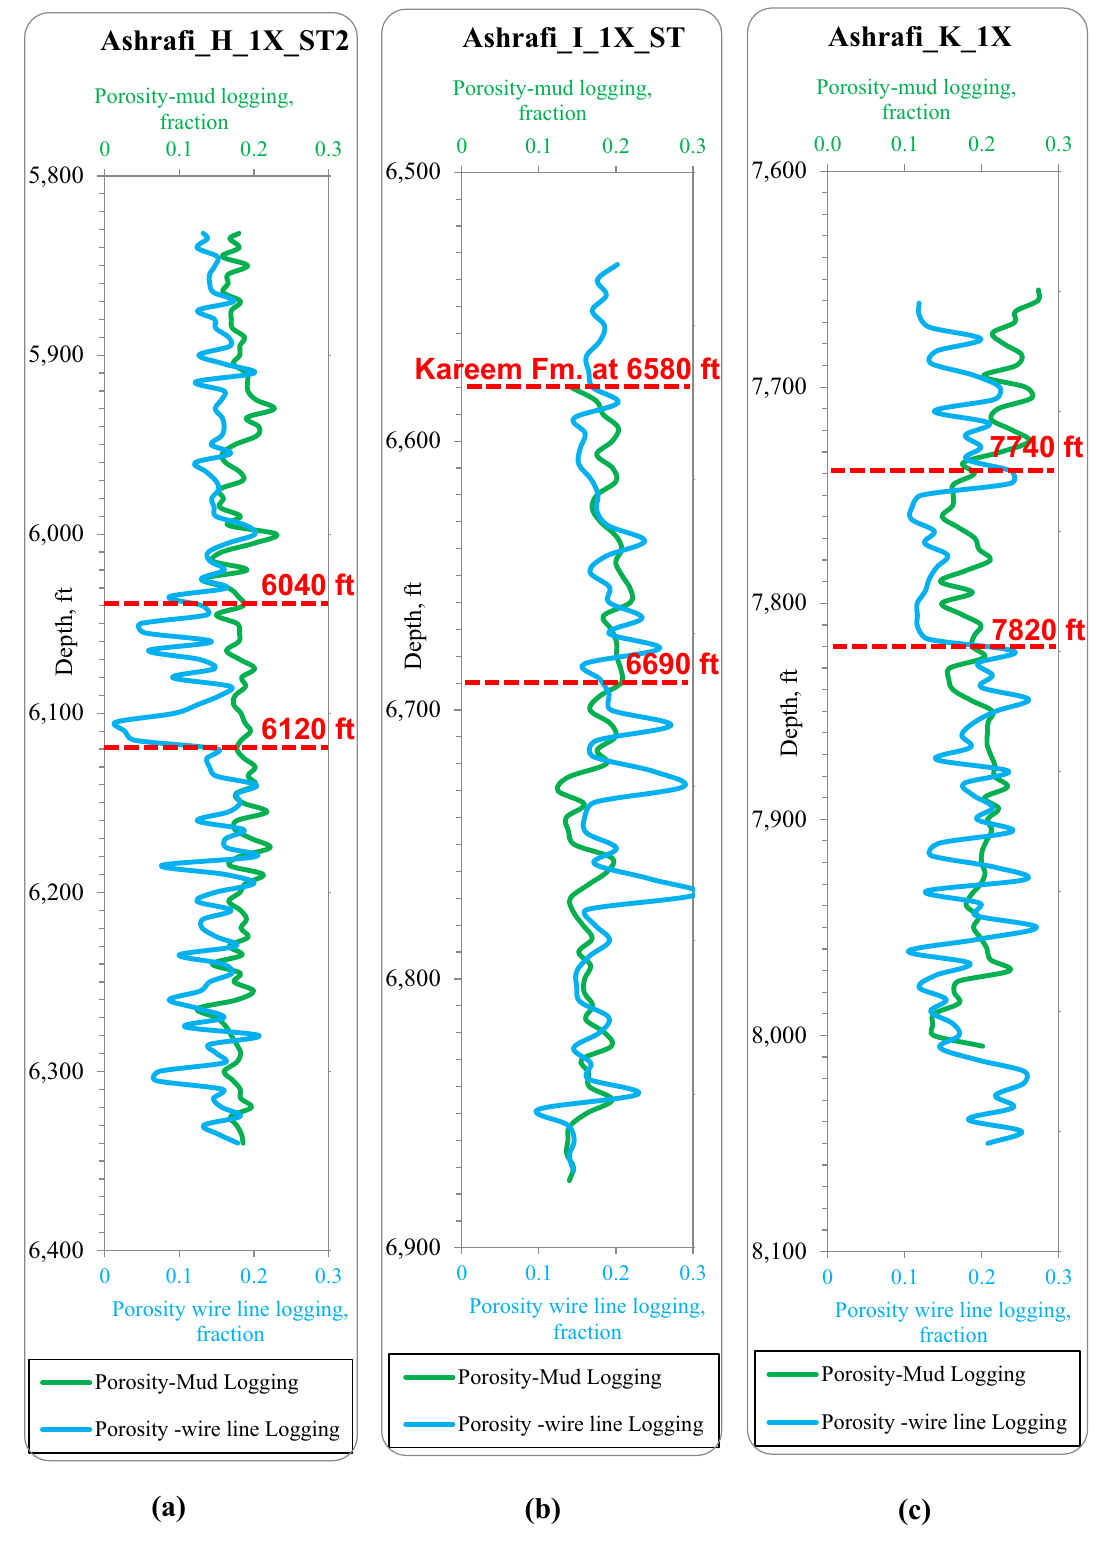
Fig. 12 Comparison between mud logging porosity (fraction) and wire-line logging porosity (fraction) with depth a Ashrafi_H_1X _ST2, b Ashrafi_I_1X_ST, and c Ashrafi_K_1X. The red dashed lines represent the possible overpressure